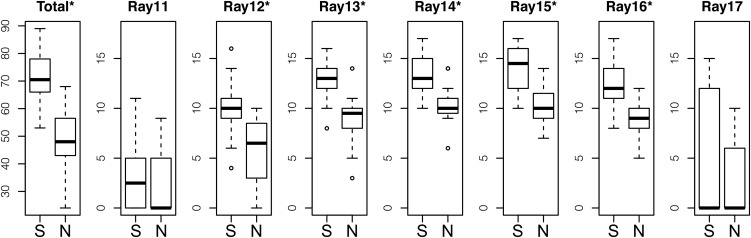
Boxplots of the number of papillary processes. The total number of papillary processes (Total) and the number of papillary process on each fin ray (Ray) were compared between the southern males (S) and the northern males (N). The asterisks indicate significant differences in the traits between crosses by the Mann-Whitney U-test (P < 0.001). N = 22 for the southern population and N = 20 for the northern population. Because only two southern males had papillary processes on Ray 10 and only one northern male had a papillary process on Ray 18, these two fin rays were not included in the analysis.